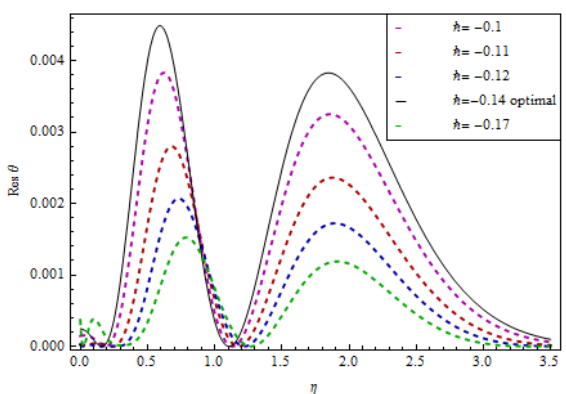
Table 2: Acceptable values of (cid:126) for alumina-sodium alginate